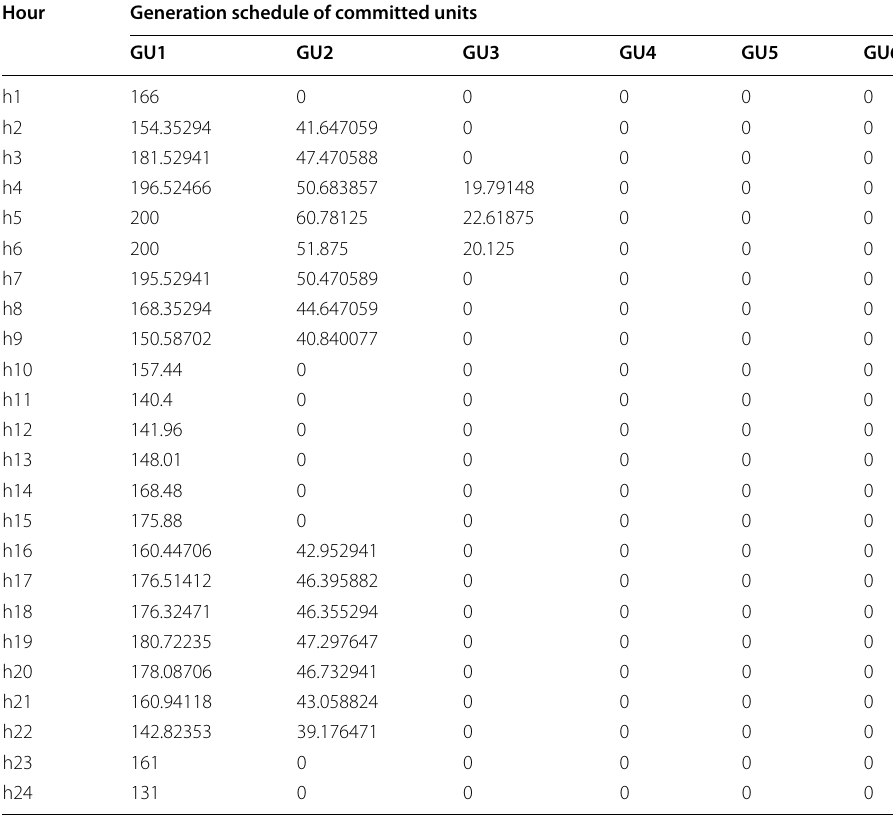
Table 13 Power scheduling for 6-generating unit system considering renewable energy in winter